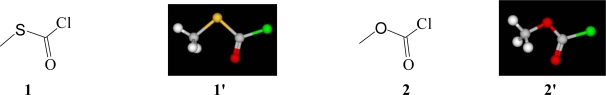
Molecular structures of S-methyl chlorothioformate (1), and methyl chloroformate (2). 3-D images for the syn conformer of S-methyl chlorothioformate (1′), and methyl chloroformate (2′).